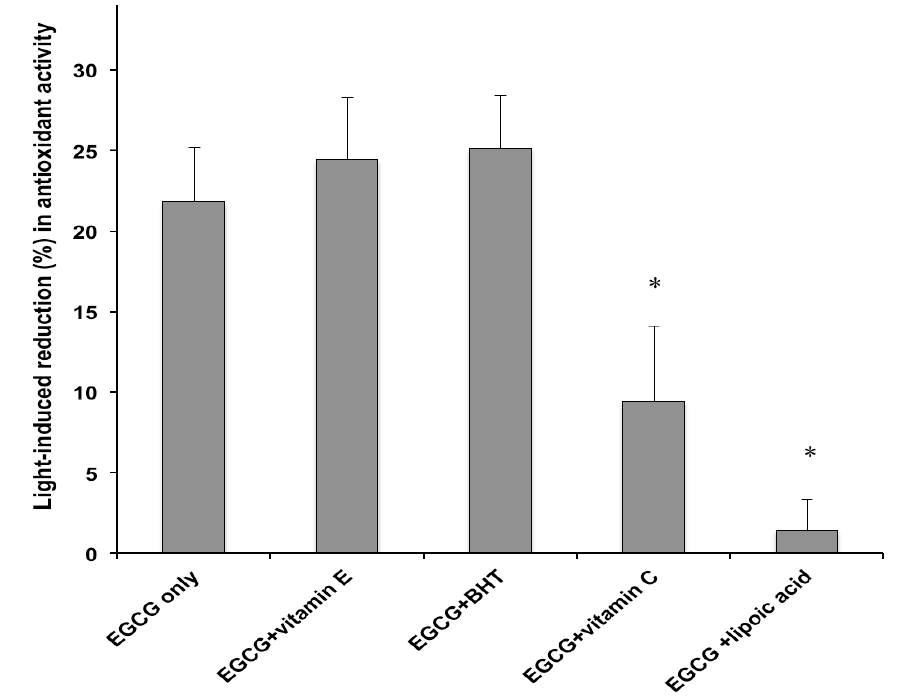
Figure 5. Antioxidant activity decrease (%) of formulations containing EGCG without or with co-antioxidants (EGCG/co-antioxidant molar ratio, 1), after 1 h irradiation with the solar simulator. Each value is the mean ± S.D. of at least six experiments. * p < 0.05 (ANOVA) vs . EGCG only.